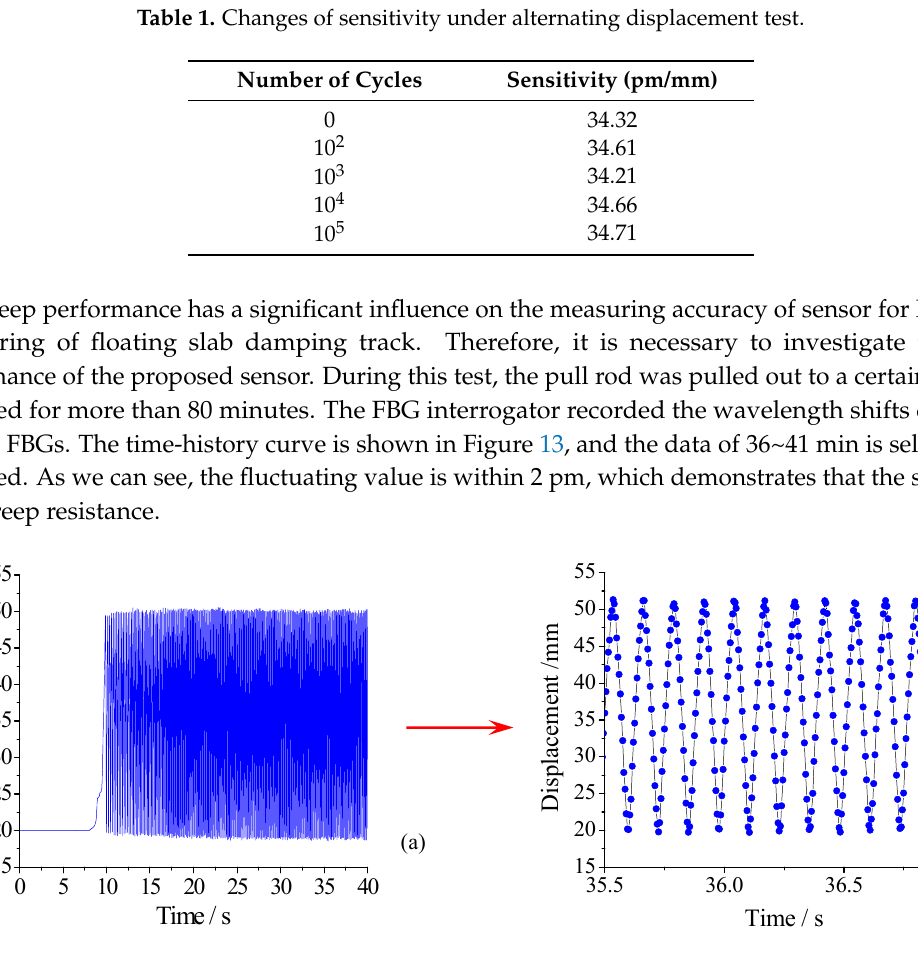
Figure 12. Part of the experimental data for alternating displacement test: ( a ) Real-time data of alternating displacement test; ( b ) The amplified data of 35.5 s~37 s.